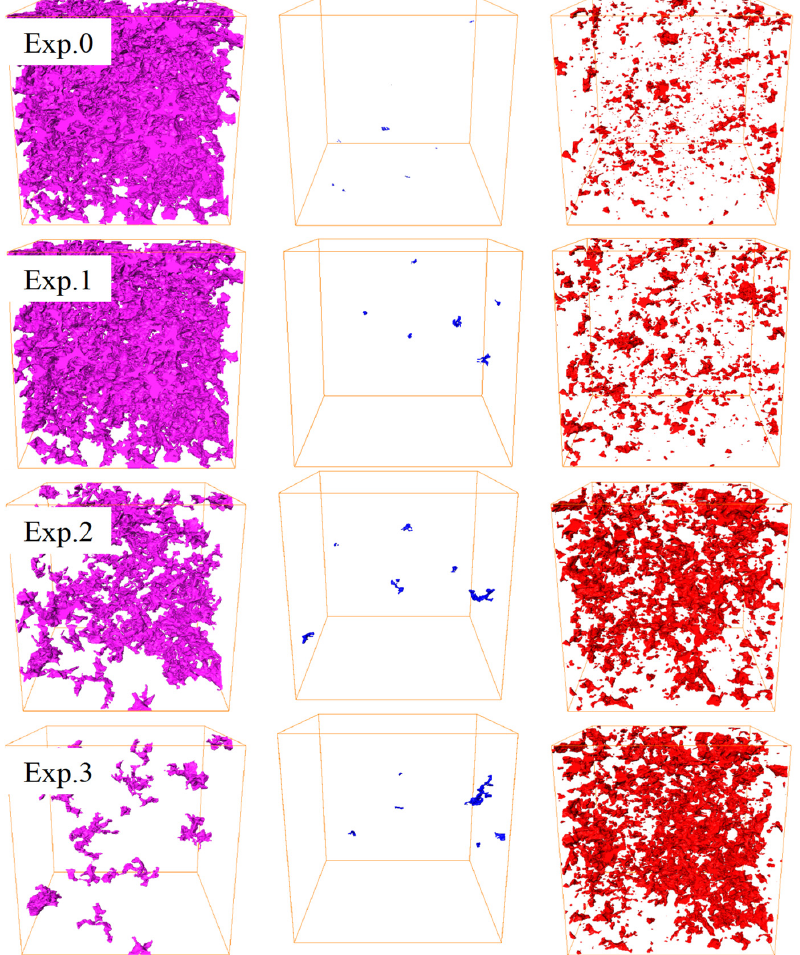
Figure 14. The characteristics of the three kinds of remaining oil in different stages.